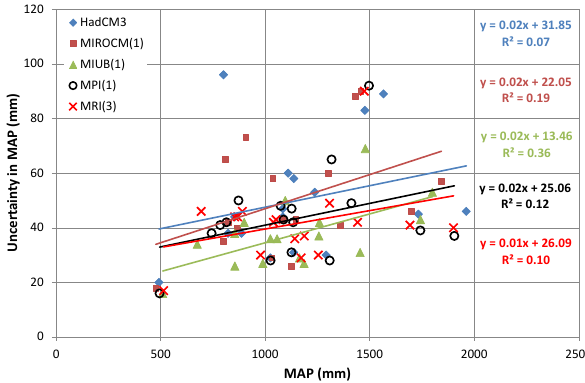
Figure 6. Within-GCM uncertainty (mmyr − 1 ) in mean annual pre- cipitation versus mean annual precipitation based on 100 replicates of monthly precipitation (1965–1994, 20C3M) for five